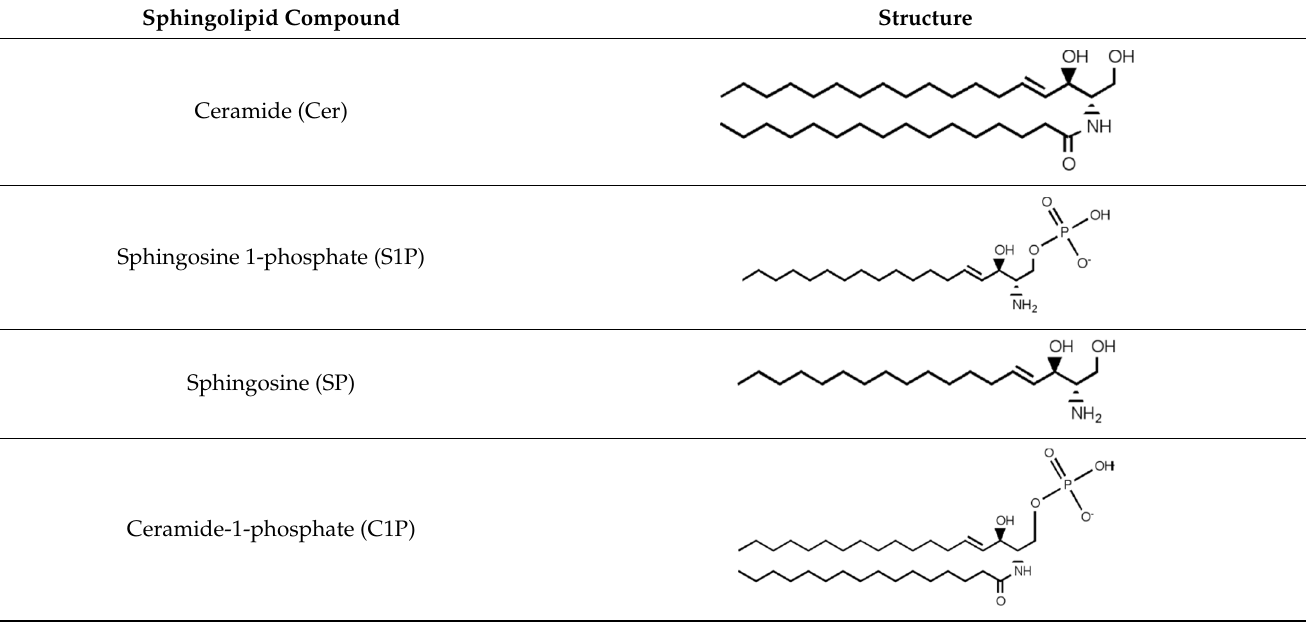
Table 2. Main sphingolipids present in human cells and their structures [21].